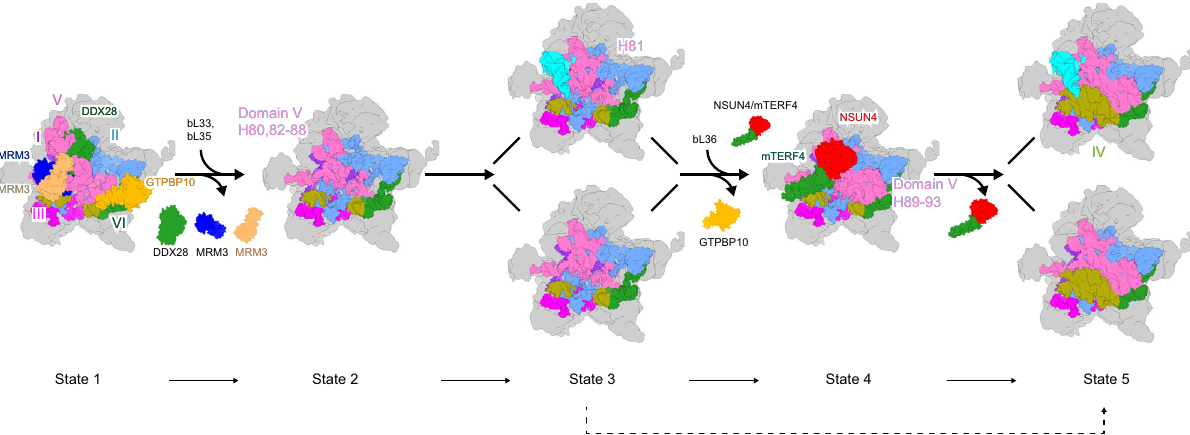
Fig. 6 Late assembly steps of the 39S mitoribosome. Cartoon depicting the late assembly transitions during the 39S mitoribosome maturation. A possible bypass from state 3 directly to state 5 is indicated with dash line. Assembly factors and the six subdomains (I – VI) of the 16S rRNA are color coded. For detailed description